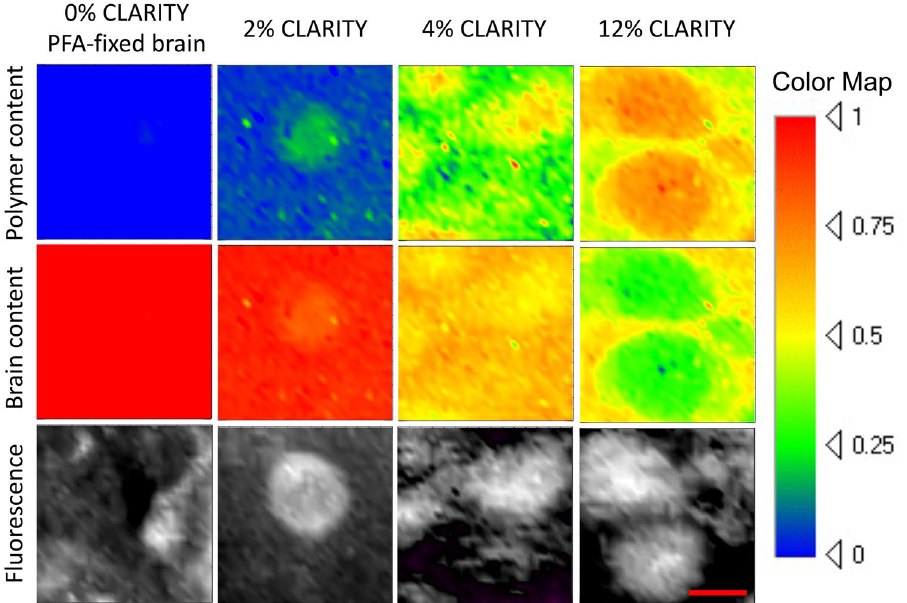
Figure 5. Confocal Raman maps (30 × 30 μm, 60 s per pixel, 1 μm step size, 2 mW laser power) of brain and polymer obtained using MLR analysis, correlated to confocal fluorescence images (30 × 30 μm cropped from 100 × 100 μm, 0.1 s per pixel, 1 μm step size, 2 mW laser power) of the same areas taken with the same Raman spectrometer immediately prior to Raman mapping, for non CLARITY PFA fixed and different AAm concentrations of CLARITY PFA fixed mouse brains. Brain tissue and polymer content together make 100% (i.e. 1 on color map), after correction for water signal. Confocal mapping was performed at least 10 μm away from